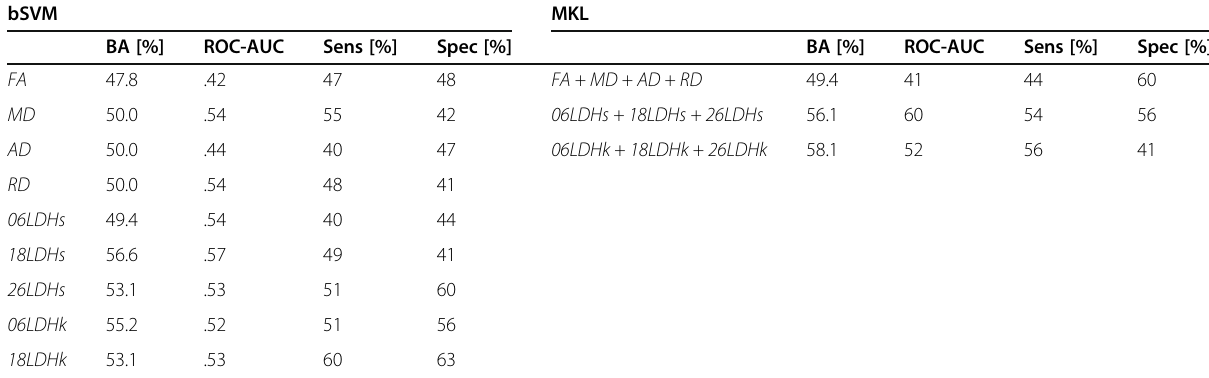
Besides BA and ROC-AUC. Sens and Spec are listed to enhance the transparency of reported ROC-AUC results AD Axial diffusivity, BA Balanced accuracy, bSVM Binary Support vector machine, FA Fractional anisotropy, LDH Local diffusion homogeneity, MD Mean diffusivity, MKL Multiple-kernel learning, RD Radial diffusivity, ROC-AUC Receiver operator characteristics area under the curve, Sens Sensitivity, Spec Specificity, SN Substantia